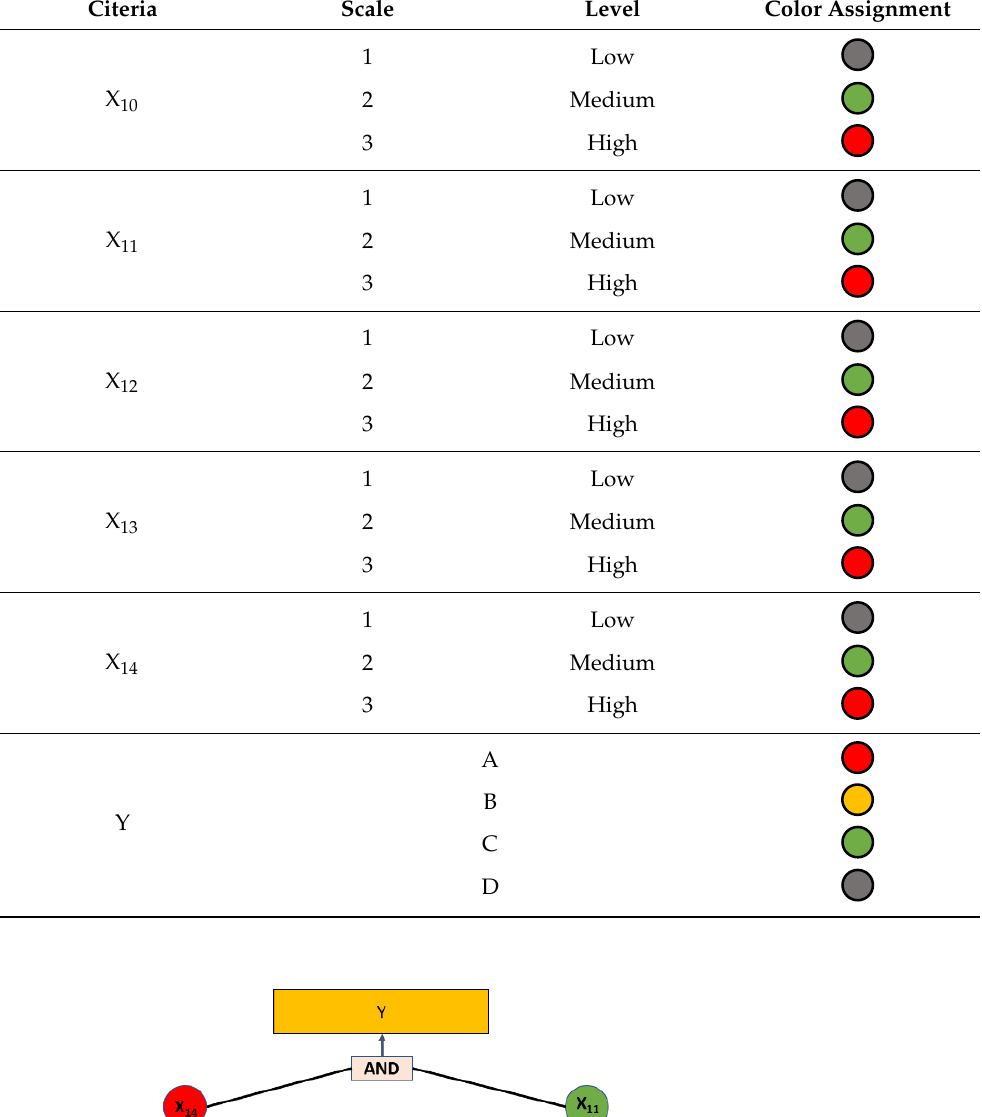
Table 3. Level and color assignment of variables.